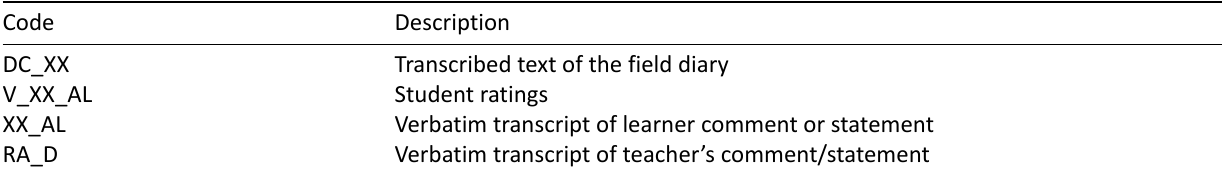
Table 1. Coding of data depending on the source of origin. Code